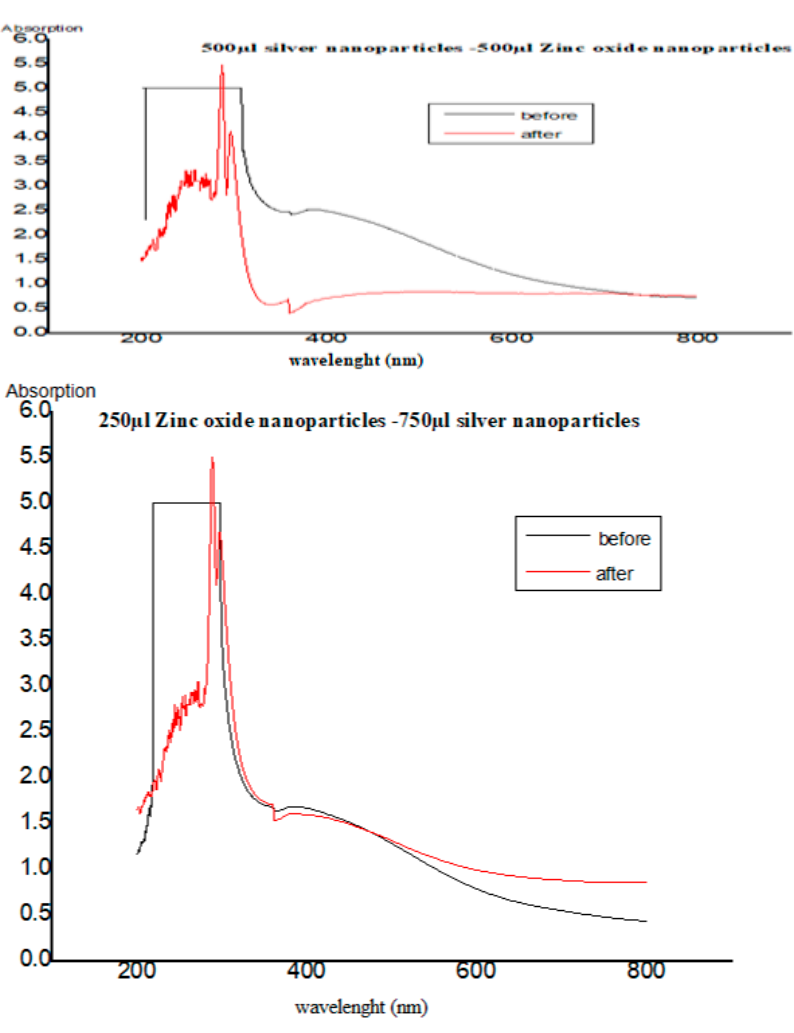
Figure 2. Ultra-violet visible spectra recorded of nanocomposites before and after